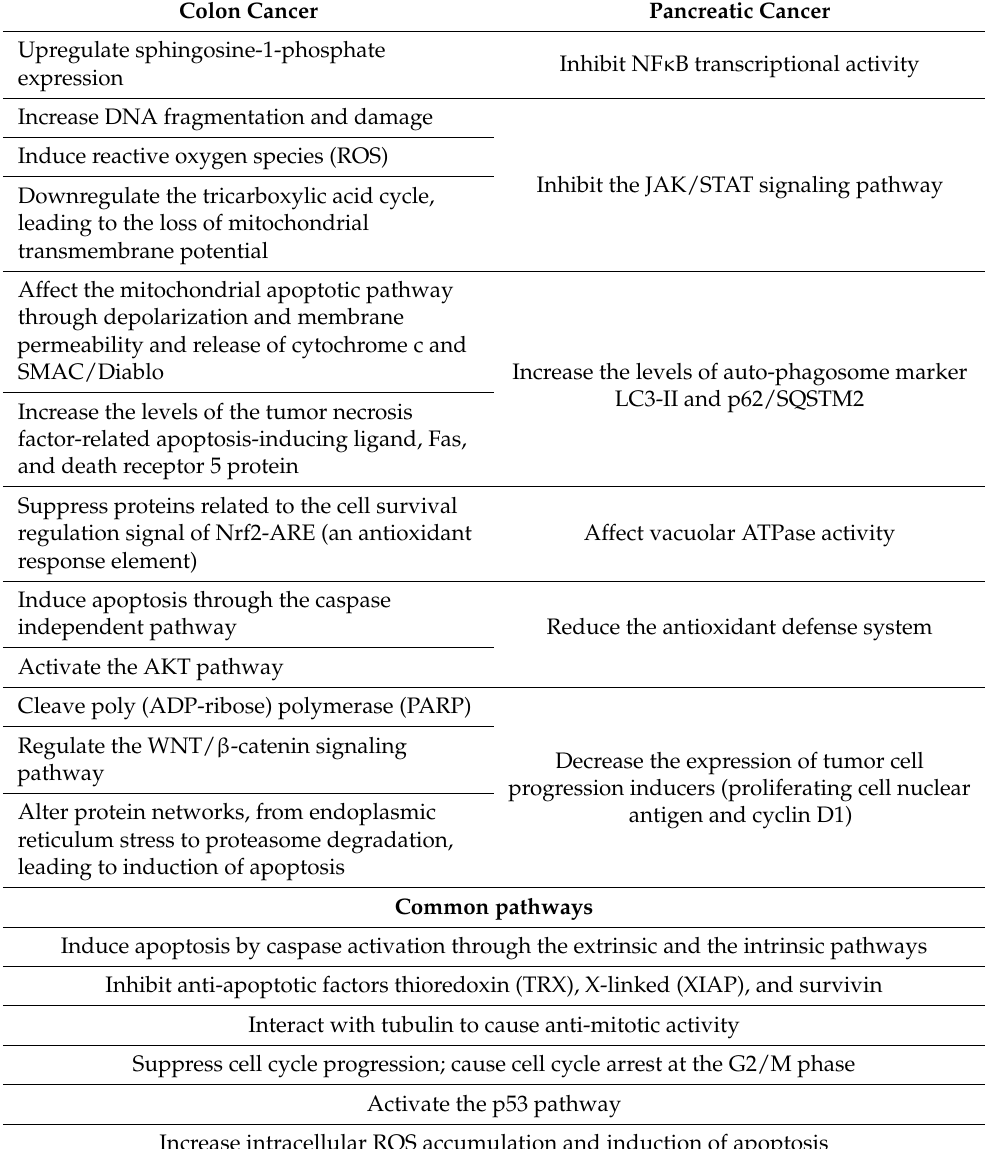
Table 3. Different and common mechanisms of action of MNPs in colon and pancreatic